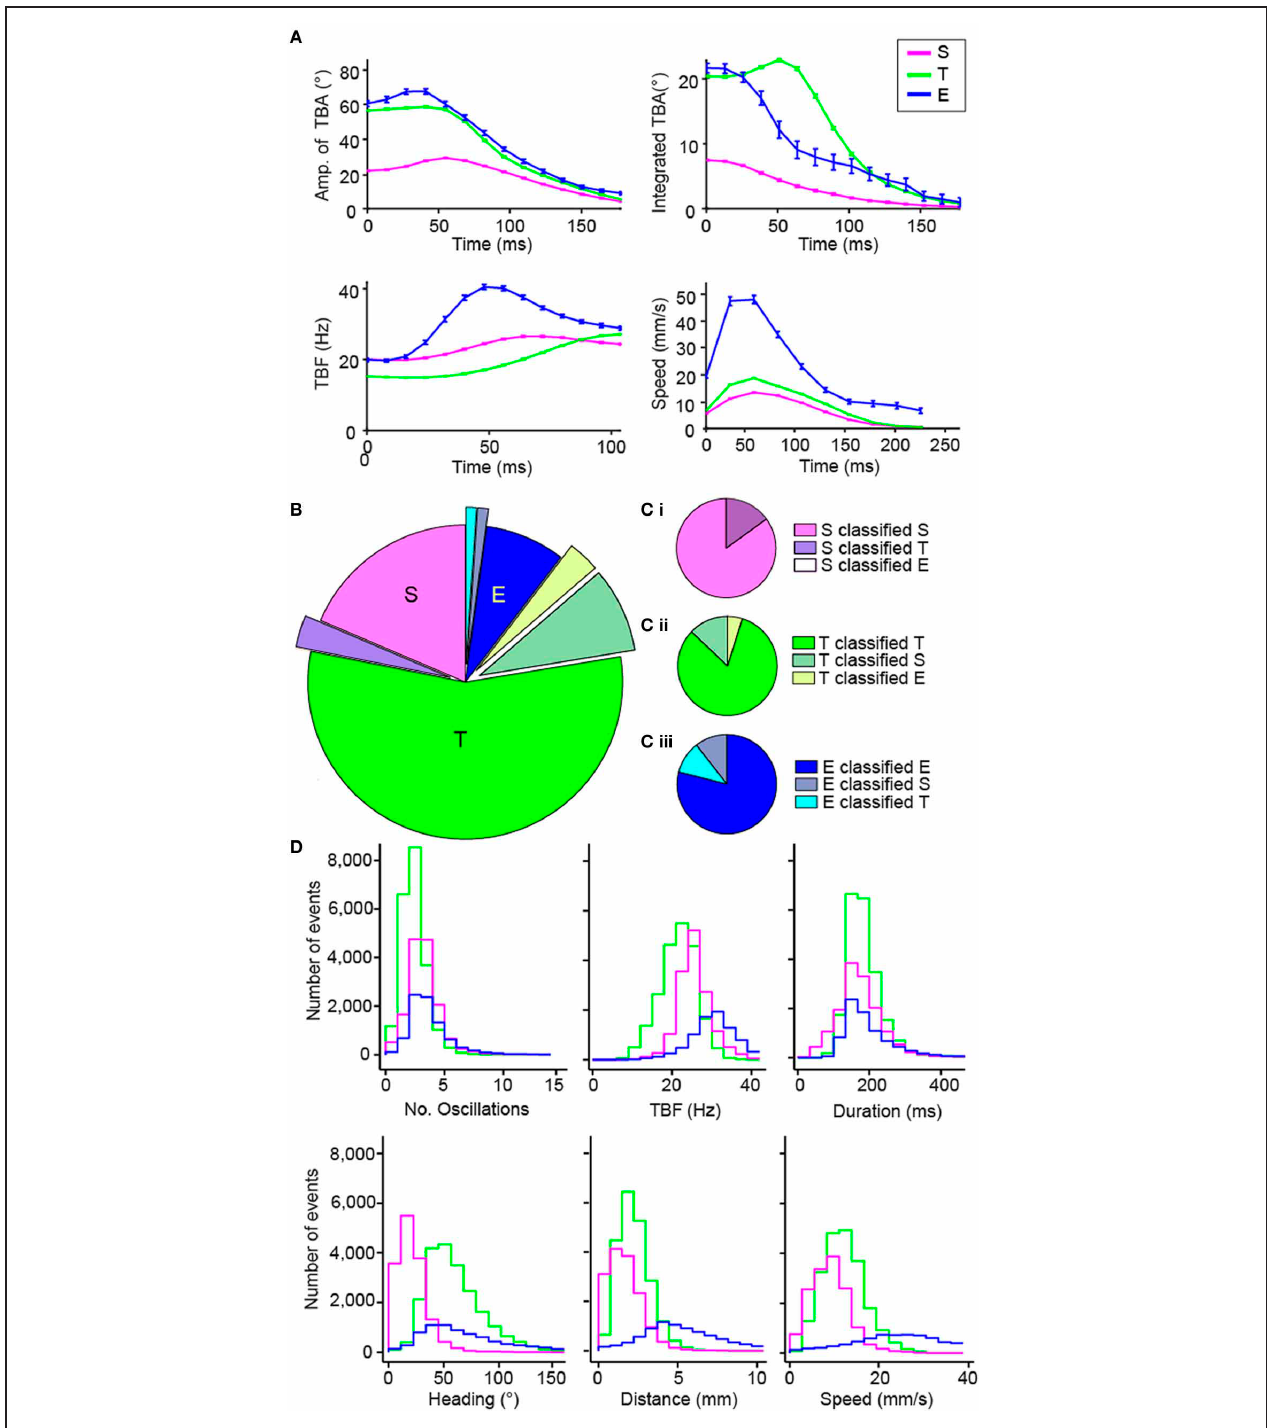
FIGURE 4 | Validation of the automated categorization of maneuvers: slow forward swim (S), routine turn (T) and escape (E). (A) Dynamic parameters used for categorizing the different maneuvers: amplitude of tail-bending angle (TBA) in degrees, integrated TBA in degrees, TBF in Hz, and speed in mm/s. The mean of each parameter for each time bin is shown and error bars are standard error of the mean: S in pink, T in green and E in blue. Time 0 is taken at the peak of the first bend of the movement. (B,C) Comparison of the results of the automatic categorization from